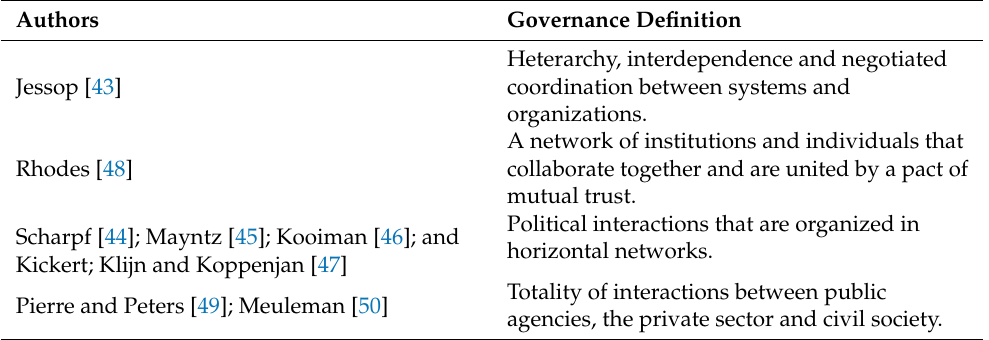
Table 1. Main governance conceptualizations in Europe